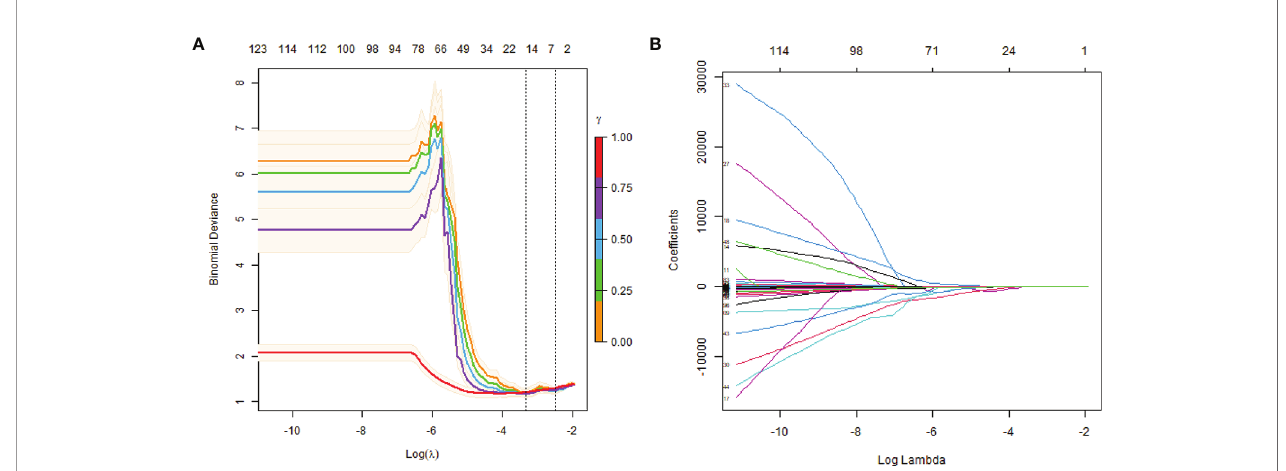
FIGURE 1 | Texture feature selection using LASSO logistic regression. (A) Selection of the tuning parameter (lambda). The dotted vertical lines are plotted at the optimal l values based on the minimum criteria and 1 standard error of the minimum criteria. (B) LASSO coef fi cient pro fi les are shown for the 1874 texture features. A vertical line is drawn at the value where the optimal lambda results in 11 nonzero coef fi